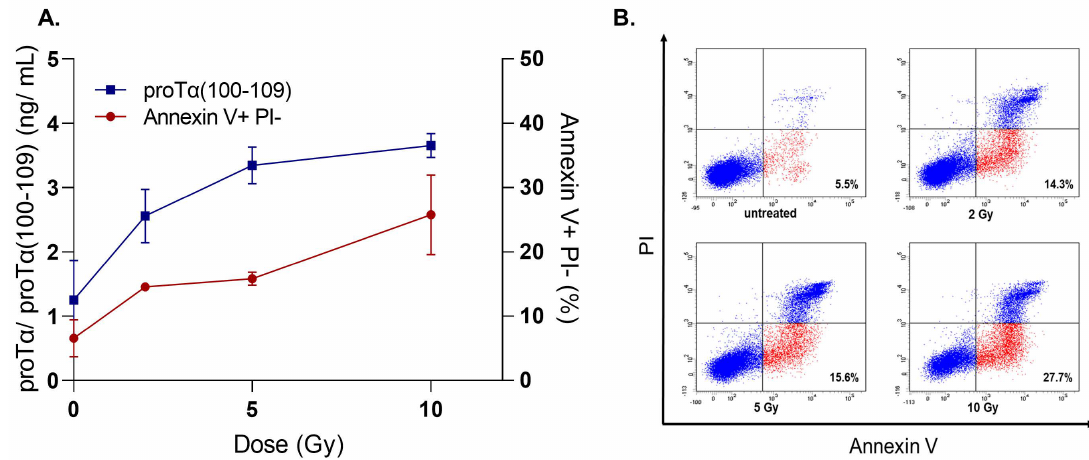
Figure 5. The levels of proT α (100–109) correlate with the percentages of early apoptotic H929 cells exposed to γ -radiation. ( A ) An overlay chart, showing the peptide’s concentration as determined in H929 culture supernatants (left axis) versus the percentages of early apoptotic (Annexin V+ PI − ) H929 cells (right axis). H929 cells were exposed to γ -radiation of 2 Gy, 5 Gy, and 10 Gy and analyzed 72 h post irradiation. Values are means ± SD from three individual experiments performed. ( B ) Representative dot plots from one experiment with H929 cells exposed to γ -radiation. Other details are as in the legend of Figure